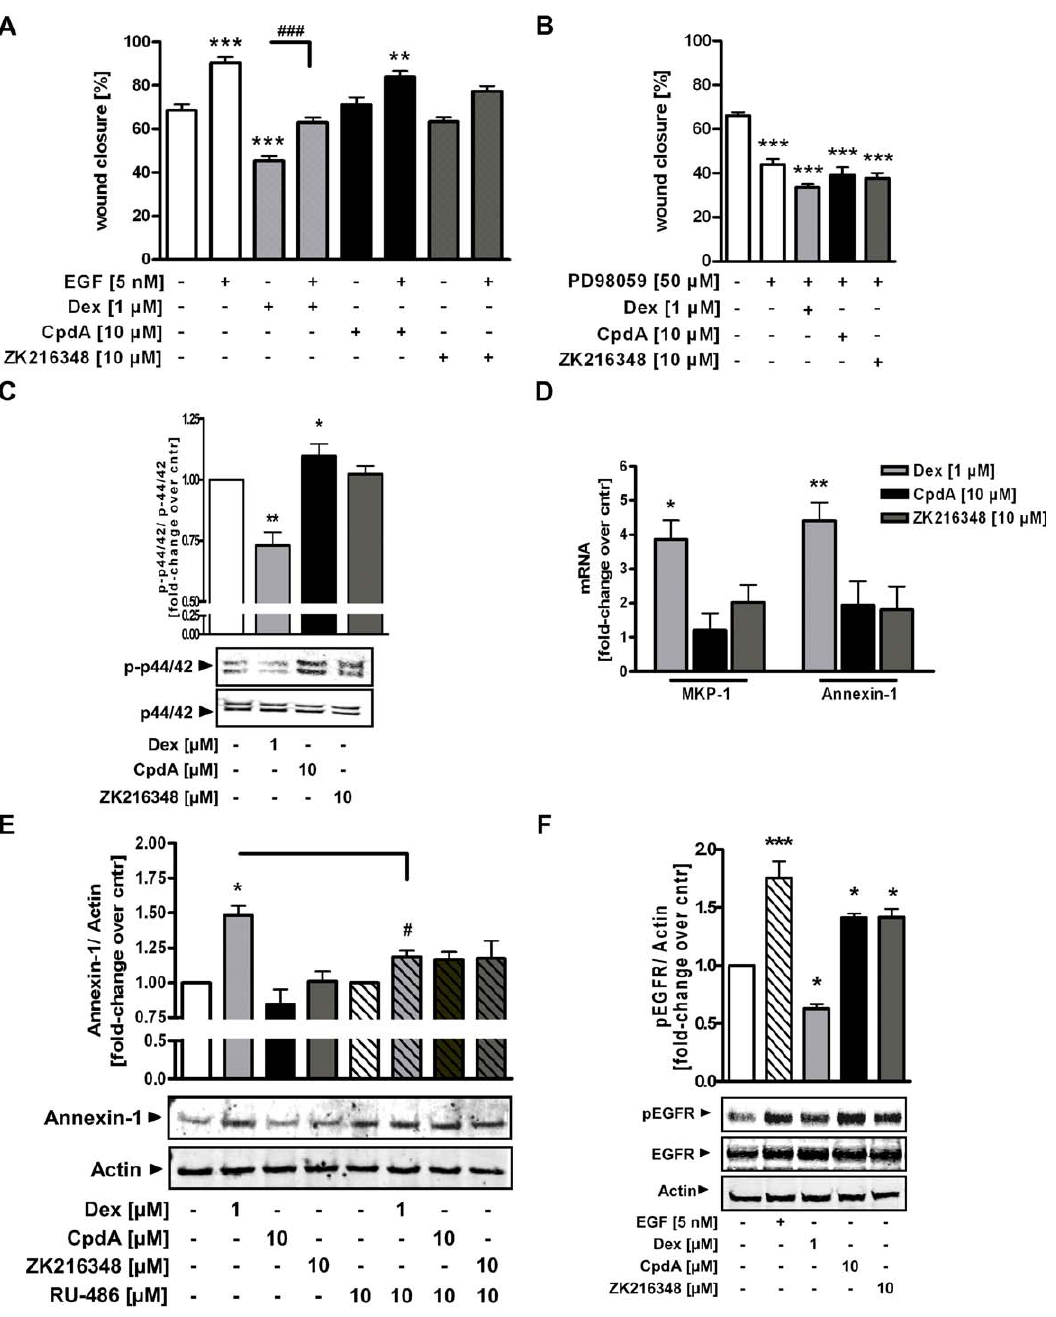
Figure 6. Effect of SEGRAs on EGF/ERK1/2/MAPK pathway - mediated intestinal epithelial restitution. Wounded IEC-6 cells were cultured for 24 h in the presence of Dex [1 m M], CpdA or ZK216348 [10 m M] with or without co-presence of ( A ) EGF (5 nM) or ( B ) specific inhibitor of MEK1/2 phosphorylation PD98059 [50 m M]. Cell migration was assessed using an in vitro migration assay. Bars indicate mean values of remaining wounded area 6 S.E.M., n=3, * P # 0.05, ** P # 0.01, *** P # 0.001 relative to vehicle, ### P # 0.001 relative to Dex. ( C ) Western blot analysis for pERK1/2 and ERK2 in Caco-2/GR cell lysates treated with Dex [1 m M], CpdA or ZK216348 [10 m M] for 1 h. One representative blot of three is shown and densitometric analysis of pERK1/2 is normalised to ERK2. ( D ) MKP-1 or Annexin-1 mRNA expression in Caco-2/GR cells after 6 h of treatment was monitored by qPCR and normalized against b -Actin. Western blot analysis for ( E ) Annexin-1 or ( F ) EGF-R protein expression in Caco-2/GR cells treated for 24 h or 1 h respectively with Dex or SEGRAs in the presence or absence of RU-486 [10 m M]. One representative blot of three is shown. Bars indicate mean 6 S.E.M., n=3, * P # 0.05, ** P # 0.01, *** P # 0.001 relative to vehicle.